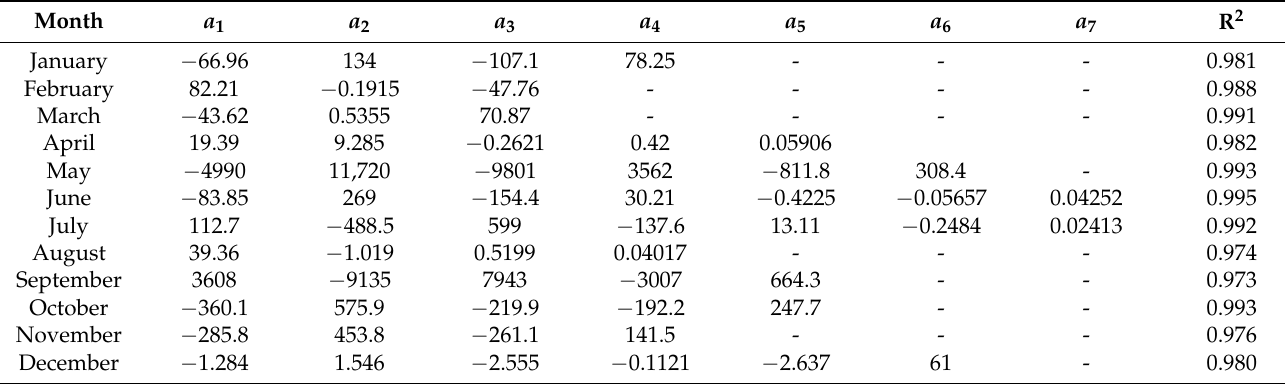
Table A2. Specific parameters of Hongjiadu